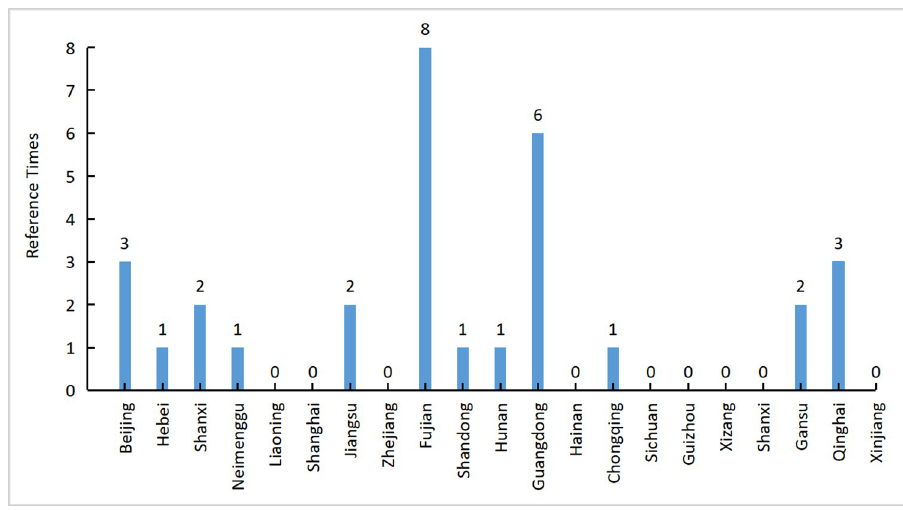
Fig 3. Reference times of high efficience